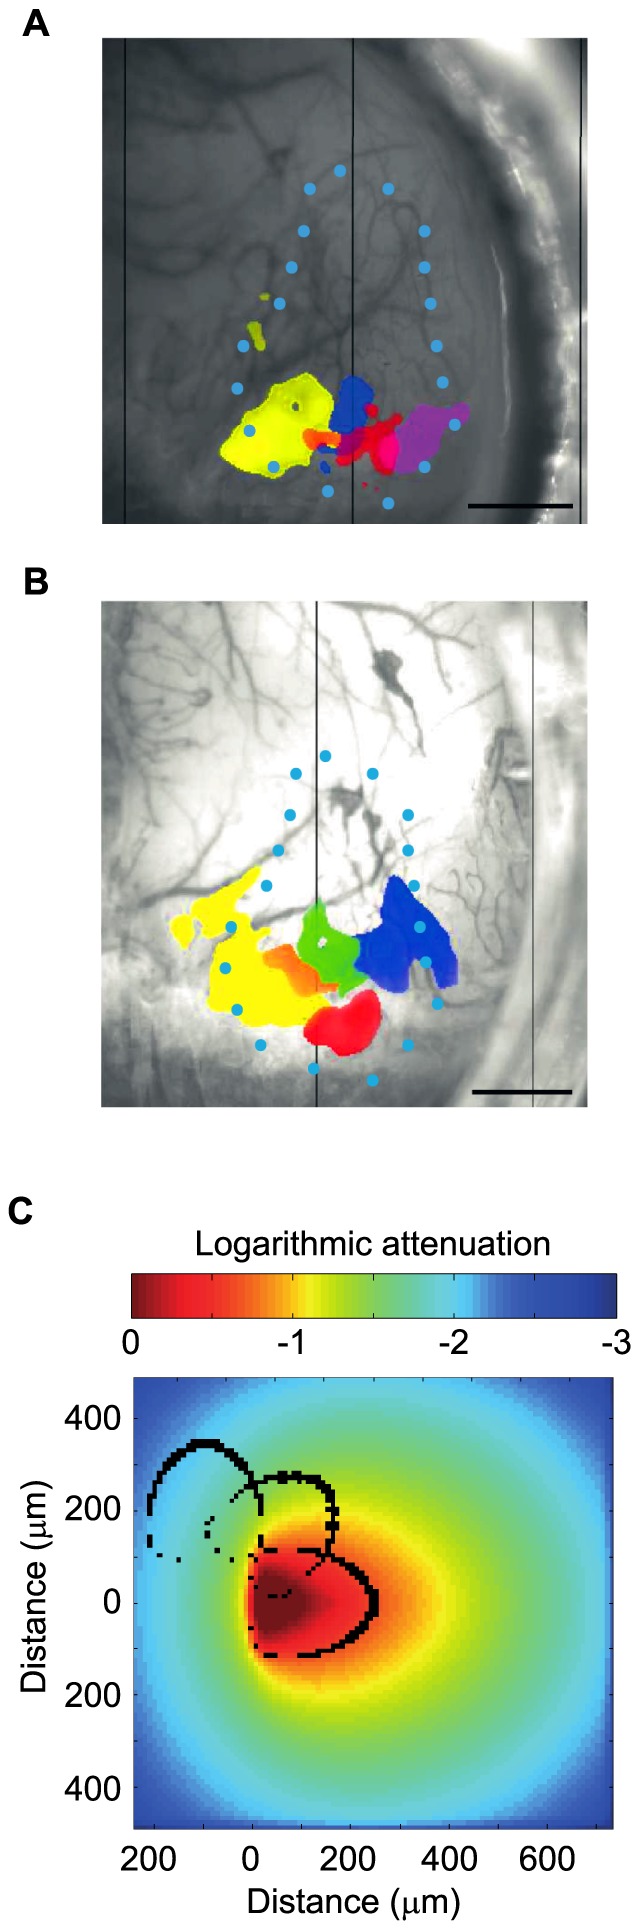
Effects of optical fiber rotation in the LGN.
A–B. Activation maps obtained with small rotation increments of the optical fiber in the LGN. Red: 0°, orange: 45°, yellow: 90°, green: 135°, blue: 180°, magenta: 270°. A. Maps obtained with rotation increments of 90°. Segregated activation maps in V1 were obtained. B. In a different experiment, increments of 45° were used. Blue dots represent V1 delineation. Threshold for activation maps: p<0.01. Scale bar: 1 mm. Light intensity at fiber tip: 2.2 mW/mm2. C. Monte Carlo simulations. Black ovals represent boundaries where neurons are illuminated by a fluence >0.5 mW/mm2, for different radial positions of the optical fiber. Rotation increments: 45°.